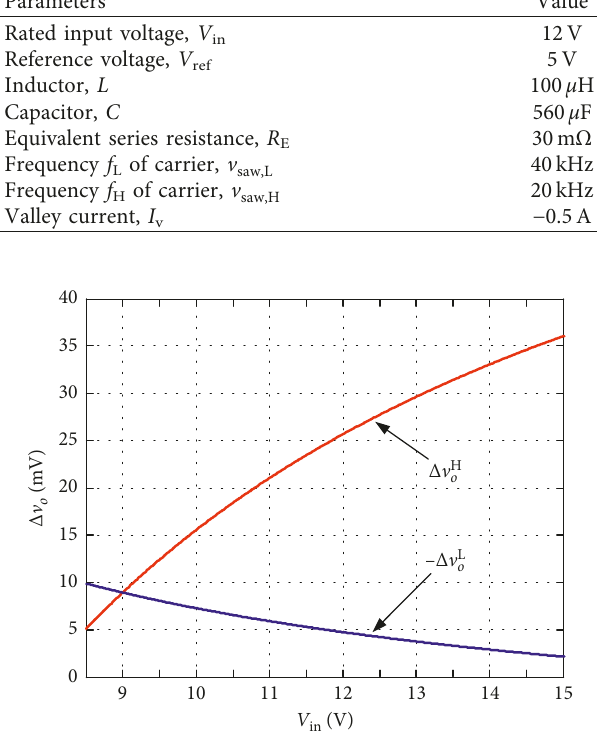
Figure 3: Output voltage variation versus input voltage of the DCPT-controlled buck converter.